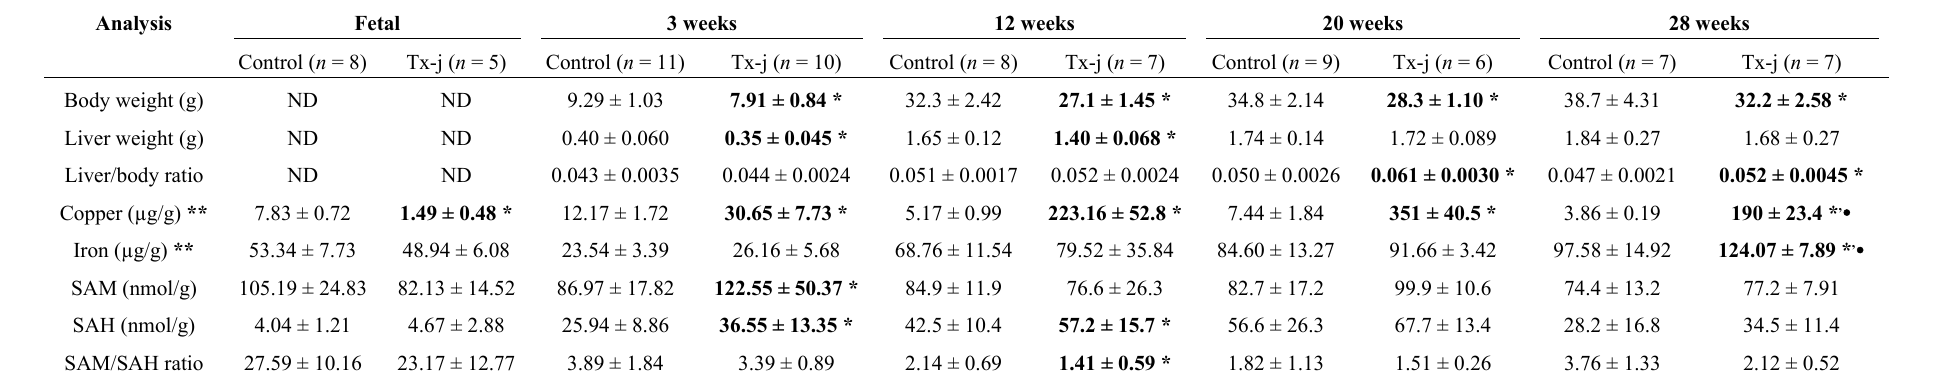
Table 1. Developmental changes (fetal–28 weeks) in body and liver weights, hepatic copper and iron, and SAM and SAH concentrations. Values are expressed as mean ± SD. Values with * are significantly different ( p < 0.05) between tx-j vs . control at each time point; ** Copper and iron concentrations at the three weeks time points are from livers of 8 controls and 5 tx-j mice; Values with  are significantly different ( p < 0.05) within the same genotype between 20 and 28 weeks. ND = not determined. Fetal and three weeks data were previously published